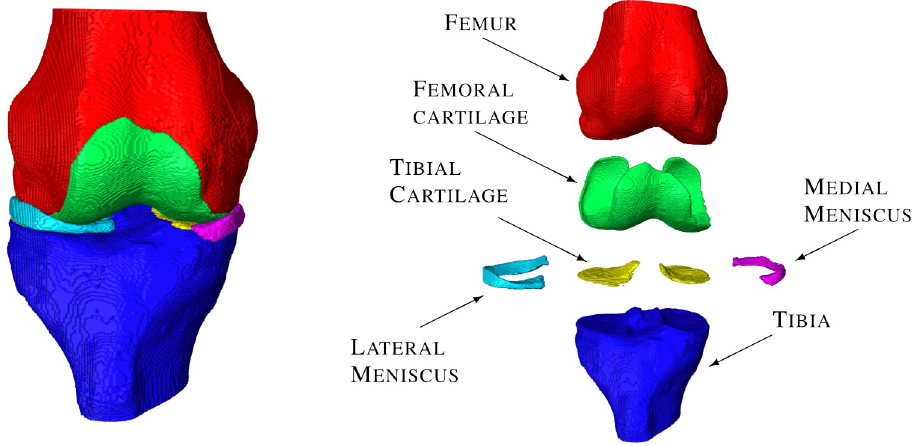
Fig 1. Anatomical regions of interest resulting from the automated segmentation methods. Our automated segmentation methods yield segmentation masks for the femoral bone, tibial bone, femoral and tibial cartilage, and both